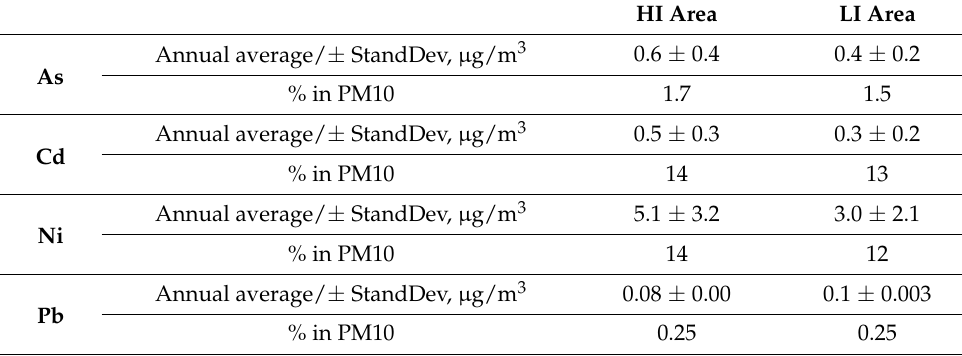
Table 4. PM10 metal concentration for HI and LI area during